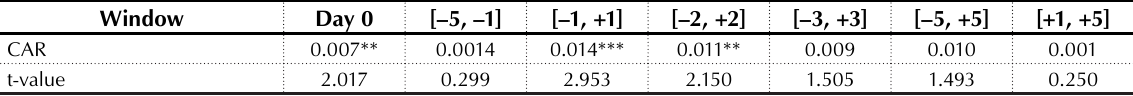
Table 4. Cumulative abnormal returns for Chinese acquirers